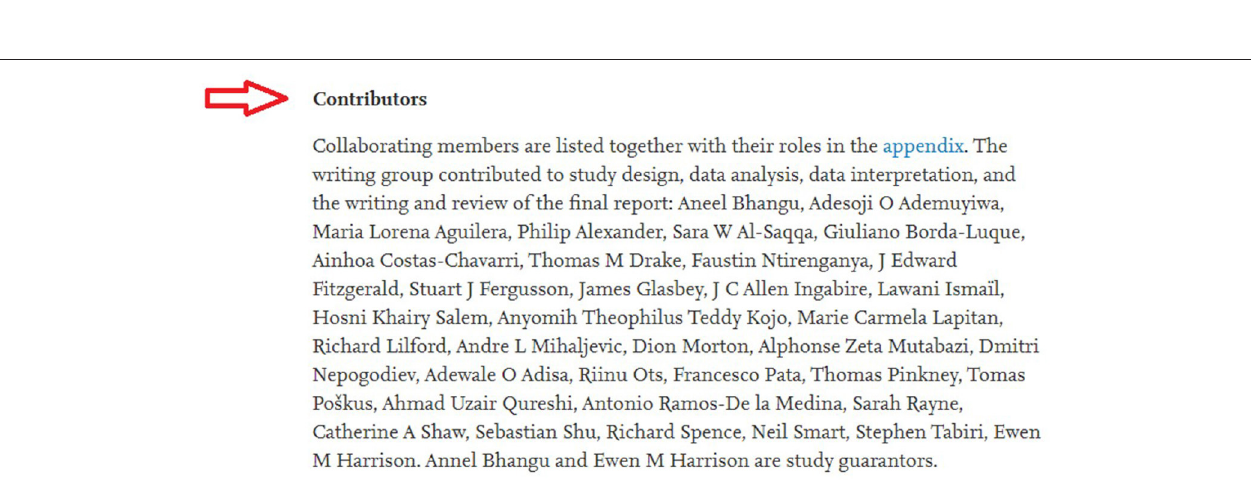
FIGURE 2 | Illustration for the method of listing authors’ contribution in a global multicentre study